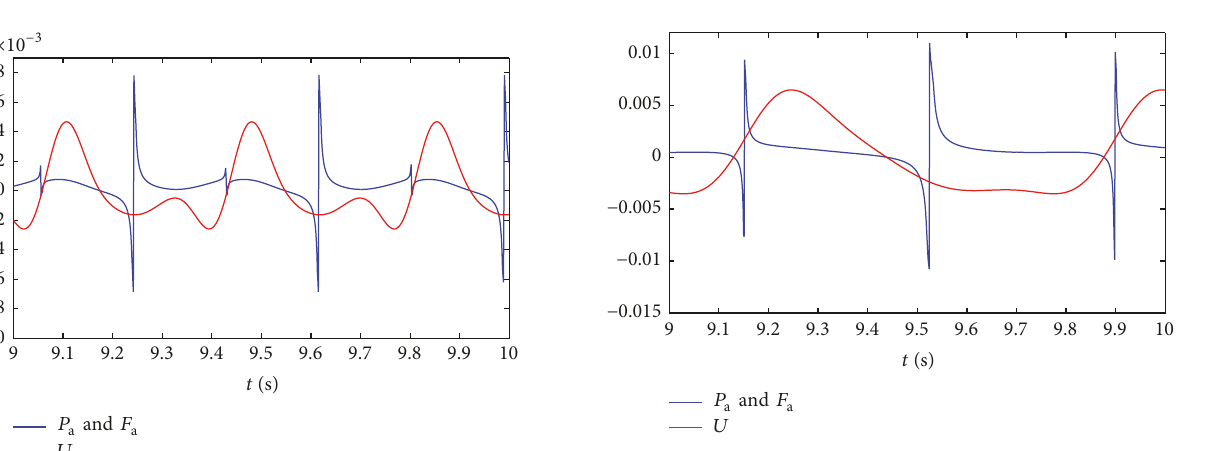
Figure 14: PD control signal for constant velocity ( 𝑥 2∗ = 8.415 rad/s = 10 km/h) with double-cylinder excited by pressure